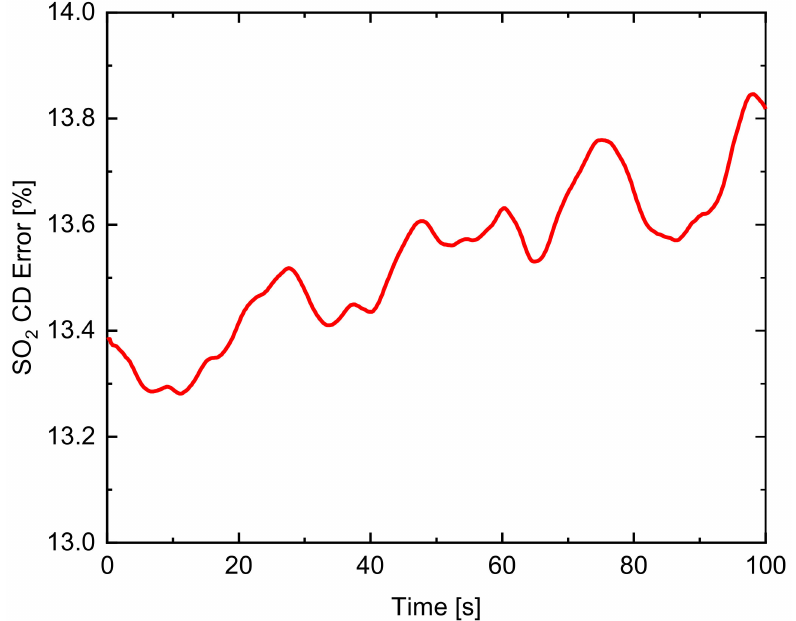
Figure 9. Time series of the error of the SO 2 CD retrieved from the UV SO 2